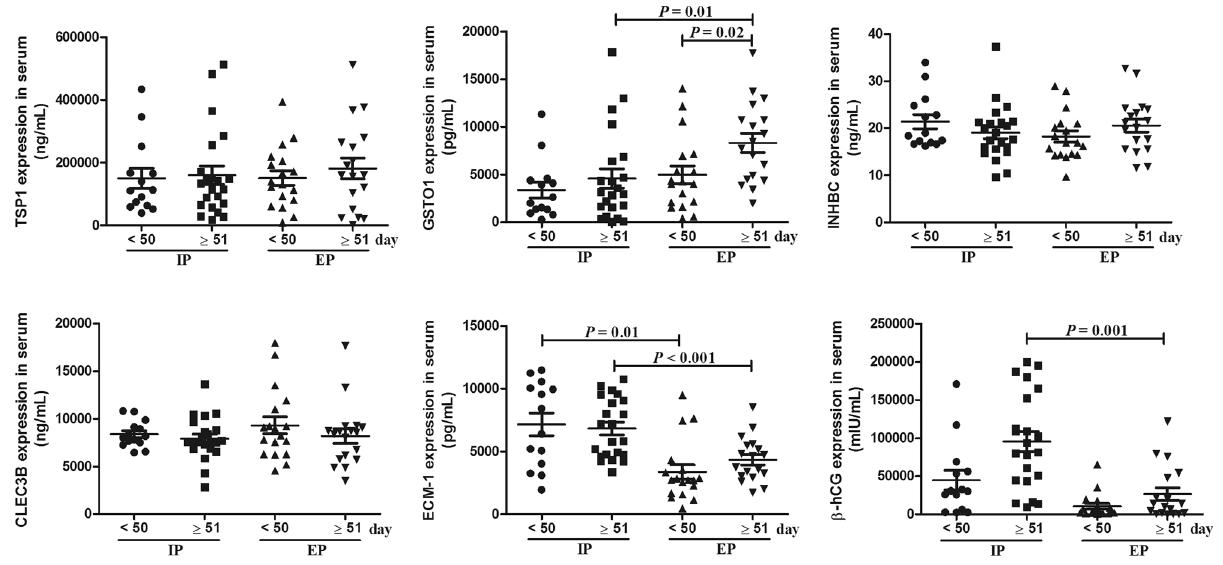
Figure 3. Subgroup analysis of concentrations of TSP1, GSTO1, INHBC, CLEC3B, ECM-1 and β-hCG in serum of IP and EP women according to gestational age (< 50 vs. 51 days). Data are presented as the mean ± standard deviation.